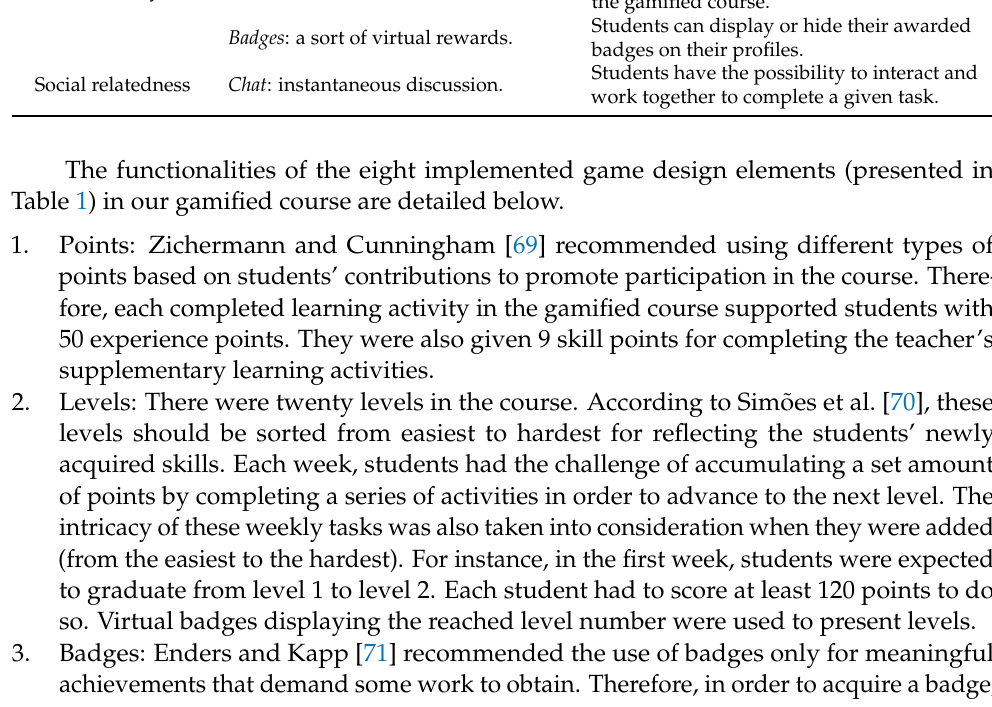
Table 1. Implemented game design elements in OODM course. Psychological Game Design Elements Needs